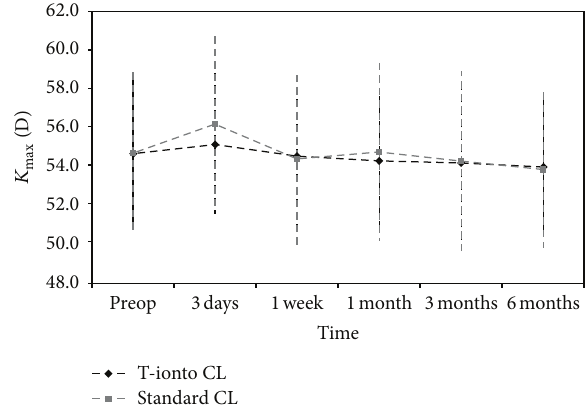
Figure3:Graphshowing 𝐾 max readings(D)comparedwithbaseline at 3 days, 1 week, and 1, 3, and 6 months after T-ionto CL (black curve)andstandardCL(greycurve).Barsindicate ± standarddevia- tion.Onaverage,bothprocedureshaltedprogressionofkeratoconus during 6 months of